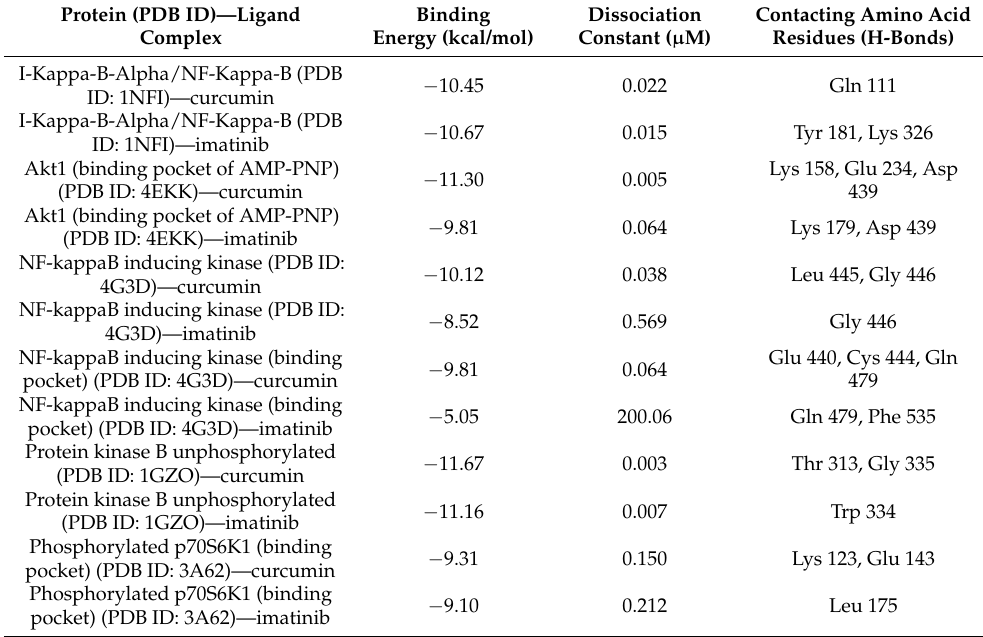
Table 2. Molecular docking parameters for curcumin and imatinib with target